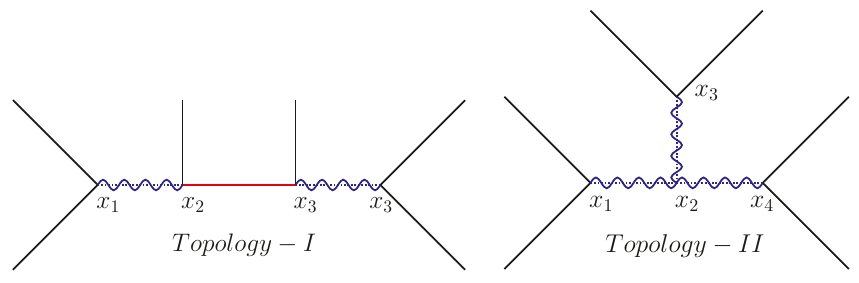
Figure 3 . The two basic tree-level topologies realising a dimension nine n - ¯ n operator. Internal lines can be fermions (solid), or scalars / vectors (crossed wavy